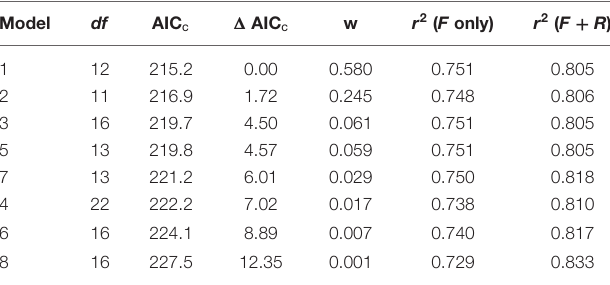
Table of candidate LMERs explaining time to approach the probe in relation to the interaction between the location of the presented probe and the gestation time for pigs that reached the 70% learning criterion only (n = 13). Each model retained all fixed terms (Location * Gestation time + Location 2* Gestation time) with only the random model